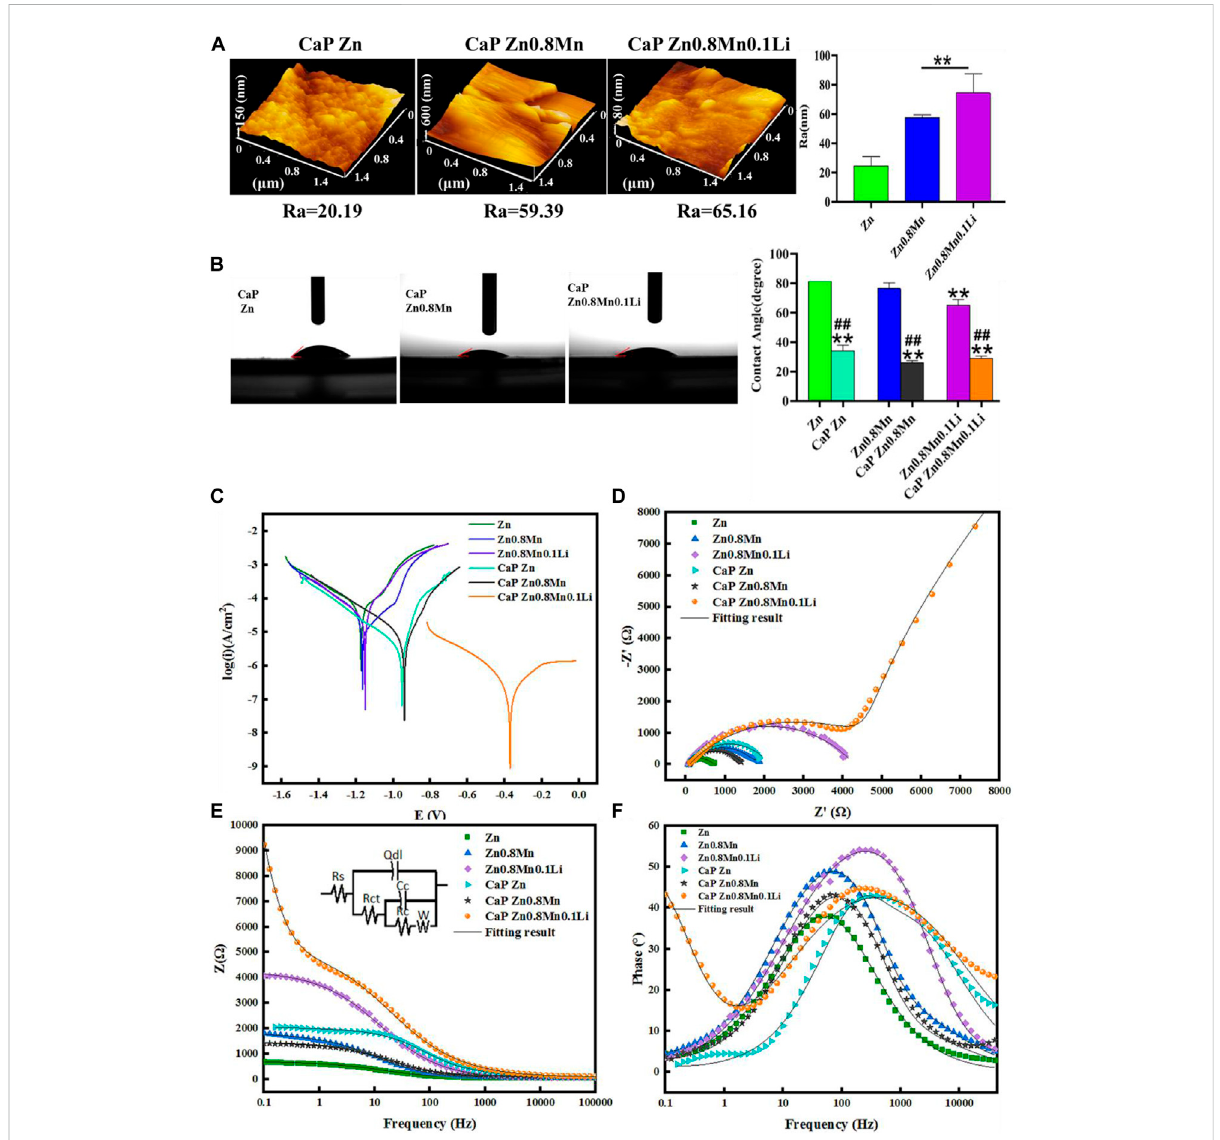
FIGURE 7 CharacterizationofCaP-coatedZn, Zn0.8Mn,and Zn0.8Mn0.1Li. (A) Thesurfaceroughness ofthesurfacesobtained byAFM. (B) Watercontact angles. (C) PotentiodynamicpolarizationcurvesofCaPZn,CaPZn0.8Mn,andZn0.8Mn0.1Li. (D) Nyquistplots. (E) Bodeplotsof|Z|vsFrequency.The insets in Figure 7E is equivalent circuit for fi tting the EIS spectra. (F) Bode plots of phase angle vs Frequency. * p < 0.05 compared to pure Zn, ** p < 0.01 compared to pure Zn, ## p < 0.01 compared to no